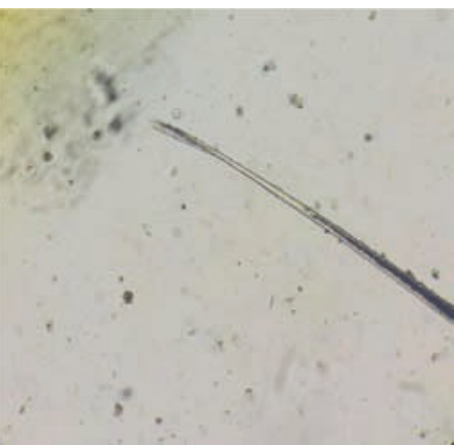
Fig. 2. Hair shaft fracture (10X) Fig. 1 . Hair bulbs in telogen phase